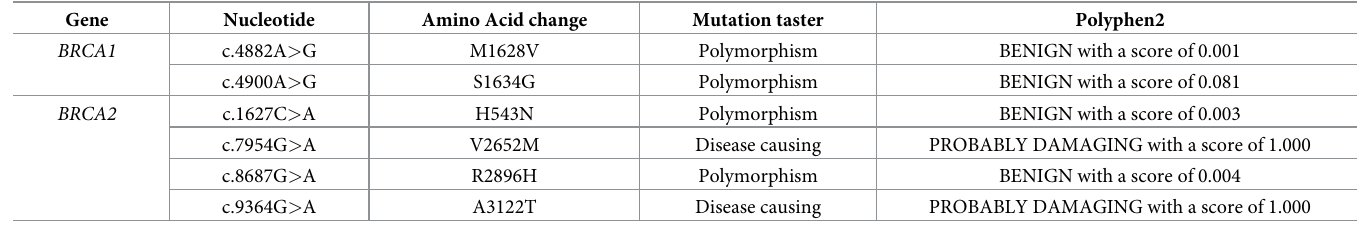
Table 4. Protein prediction of uncertain significance BRCA1/BRCA2